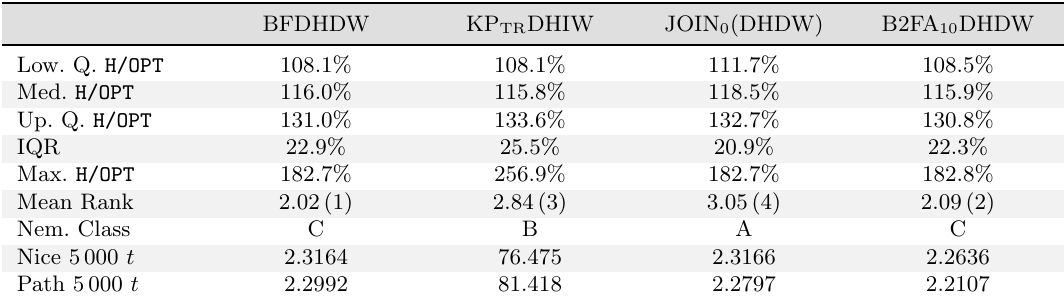
Table 2: A summary of the results achieved by the best level-packing algorithms cited in this paper when applied to the 1 170 strip packing benchmark problem instances listed in Table 1. The row labelled ‘Median H/OPT ’ contains the median packing height for all benchmark instances as a percentage of the optimum packing height, or its lower bound if the optimum is not known. The row labelled ‘Low. Q. H/OPT ’ contains the value of the lower quartile, the row labelled ‘Up. Q. H/OPT ’ contains the values of the upper quartile and the interquartile range (in the row labelled ‘IQR’ ) is the difference between the two. The row labelled ‘Max. H/OPT ’ contains the worst result achieved by the algorithms for all benchmark instances. The row labelled ‘Nem. Class’ contains results obtained by means of a Nemenyi test. Algorithms in the same group (indicated by alphabetic letters) do not produce results that are significantly different. The row labelled ‘Mean Rank’ contains the mean ranks achieved by the algorithms (a rank of 1 indicates that the algorithm packed to the lowest height for an instance), with their ranks shown in parentheses. If algorithms yielded the same packing height for an instance, the mean of the ranks that would have been awarded had these ranks been different was used in the analysis. The rows labelled ‘Nice 5 000 t ’ and ‘Path 5 000 t ’ show the mean solution time (in seconds) required for instances of 5 000 items (for the “nice” and “pathological” benchmark problem instances